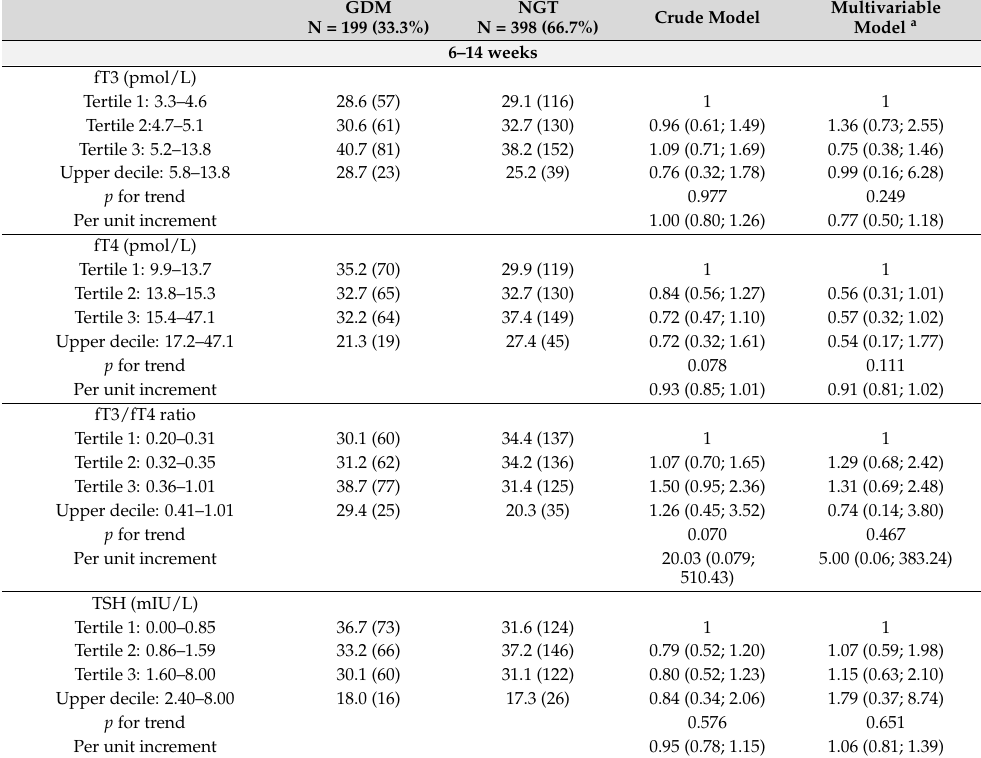
Table 2. Adjusted odds ratio’s for GDM according to tertiles of fT3, fT4, the fT3/fT4 ratio, and